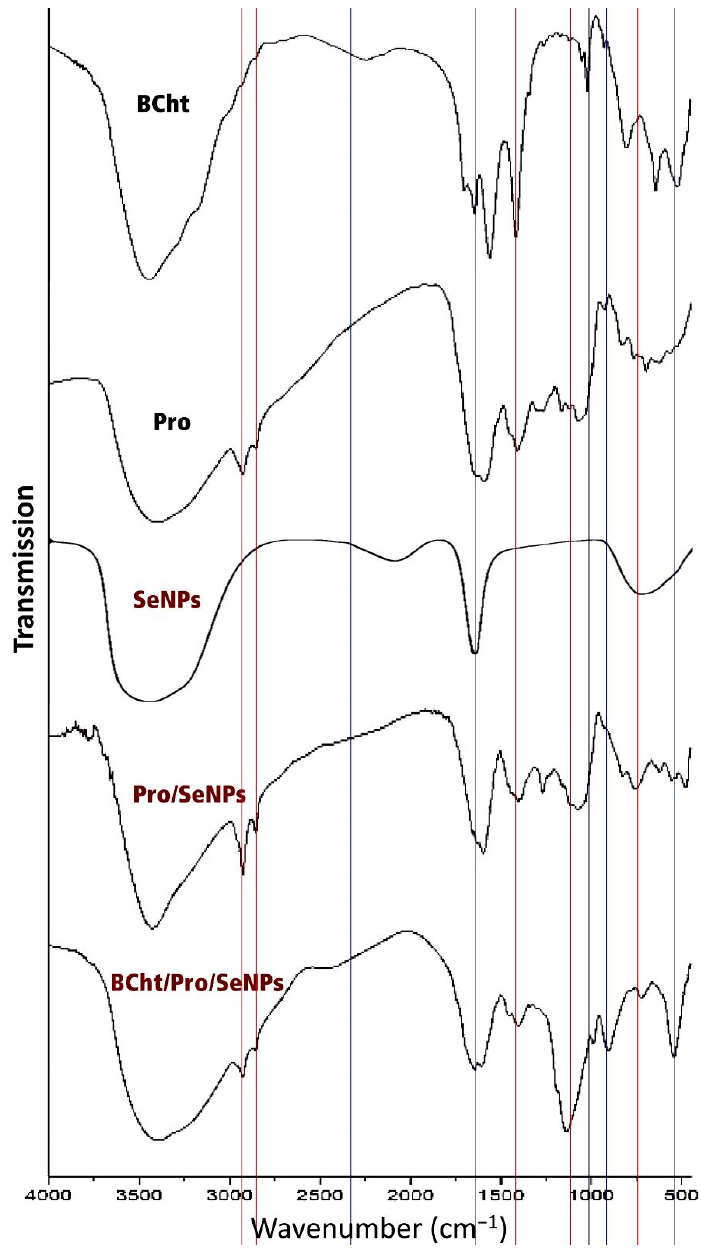
Figure 3. FTIR spectra of bee chitosan nanoparticles (BCht), propolis (Pro), Pro with synthesized SeNPs (Pro/SeNPs) and BCht/Pro/SeNPs nanocomposite.